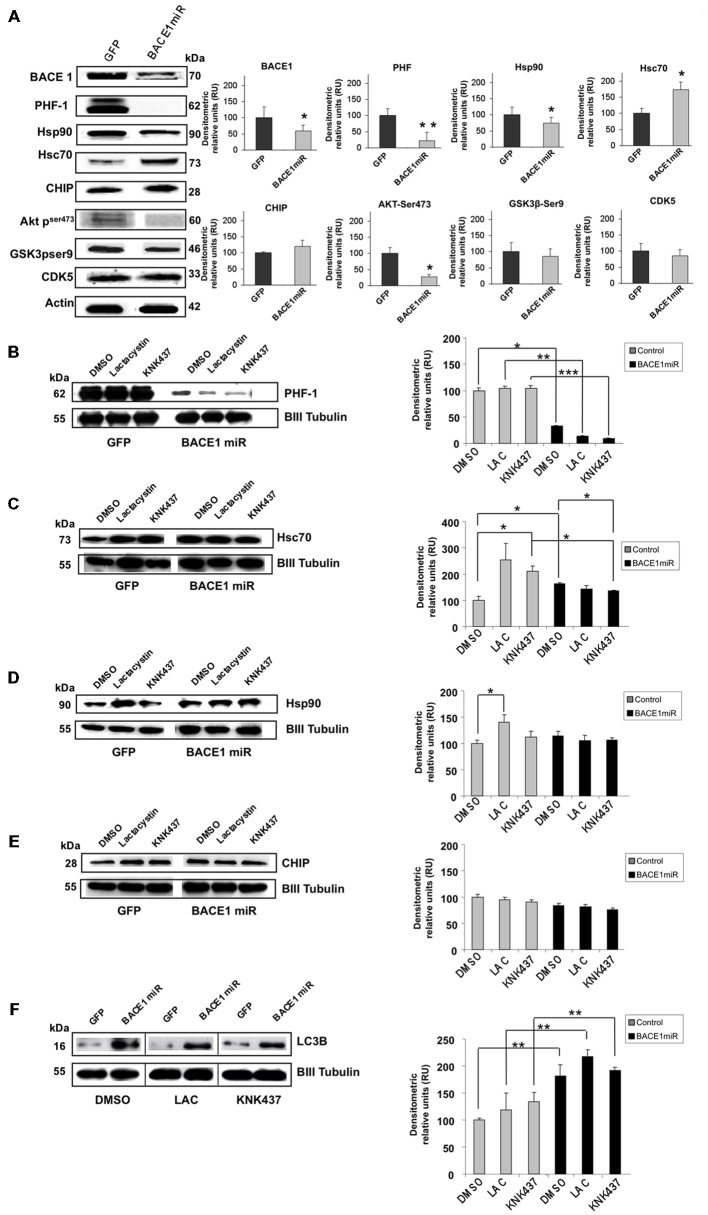
BACE1miR decreased hyper-phosphorylated tau in a proteosome-independent manner in primary neuronal cultures. (A) BACE1, PHF-1, Hsp90, Hsc70, CHIP, pAkt (ser473), GSK3 (pSer9) and CDK5 Western blots from primary neuronal cultures transduced at DIV5 (7 days transduction) with AAV2/5-BACE1miR or AAV2/5-GFP as a control. Representative blots are shown. Actin was used as a loading control. Densitometric quantification was performed; RU = relative units. n = 4, *p < 0.05, *p < 0.001. (B) Western blotting of primary cortical cultures transduced with AAV2/5-BACE1miR or AAV2/5-GFP at DIV5 for 7 days. Neurons were exposed to lactacystin (synthetic; 10 μM), KNK437 heat shock protein inhibitor I, (100 μM) or DMSO for 24 h. Representative blots of (B) PHF-1, (C) Hsc70, (D) Hsp90, (E) CHIP and (F) LC3-B. βIII-tubulin was used as a loading control. Densitometric quantification was performed; RU = relative units. n = 4, *p < 0.05, **p < 0.001, ***p < 0.0001.